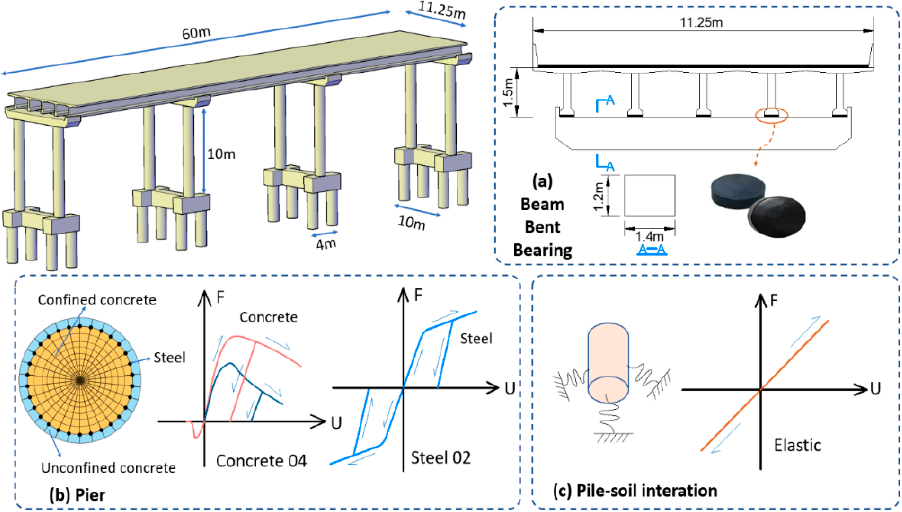
Figure 8. Schematic information of the case-study bridge. ( a ) Beam Bent Bearing; ( b ) Pier; ( c ) Pile- soil